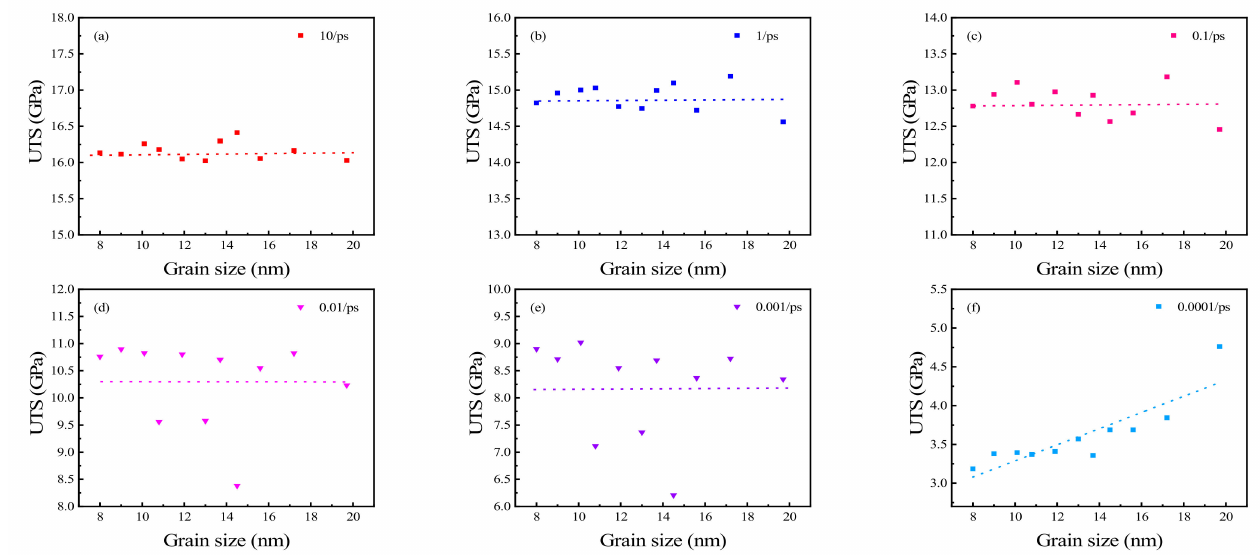
Figure 8. UTS of polycrystalline Cu 6 Sn 5 at strain rates of ( a ) 10 ps − 1 , ( b ) 1 ps − 1 , ( c ) 0.1 ps − 1 , ( d ) 0.01 ps − 1 , ( e ) 0.001 ps − 1 , and ( f ) 0.0001 ps − 1